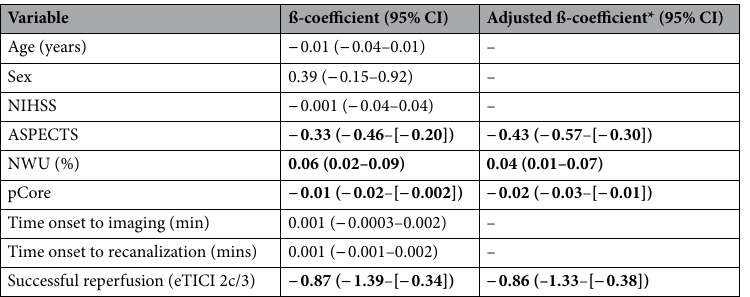
Table 3. Univariable and multivariable linear regression analysis of baseline, imaging, and procedural variables with the cubic root of lesion growth. NIHSS National Institutes of Health Stroke Scale; ASPECTS Alberta Stroke Program Early CT Score; NWU net water uptake; eTICI expanded Thrombolysis in Cerebral Infarction. *Significant predictors in univariable regression were used to build the multivariable model. Significant associations are shown in bold.